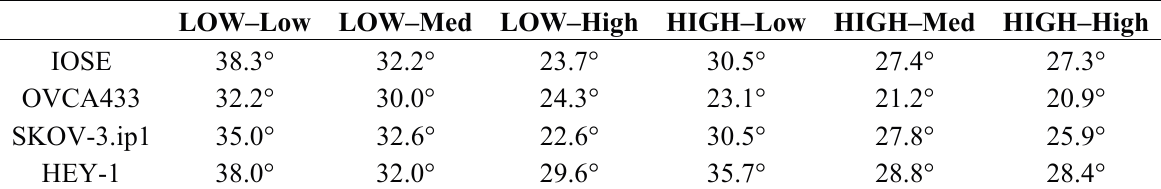
Figure 6. Histograms of the alignment of OVCA433 cells on the low ( a ); and high ( b ) LN gradients relative to the fiber axis. The alignment is further broken down into low, medium, and high concentration regions of the respective gradient. The alignments were all peaked at 0°, i.e. , parallel to the gradient but increased LN concentration resulted in narrower distributions until a saturated response was observed. Table 5. Circular standard deviations of the four cell lines on the low, medium, and high concentration regions of the low and high slope gradients. The distributions narrowed at higher concentrations for all cell